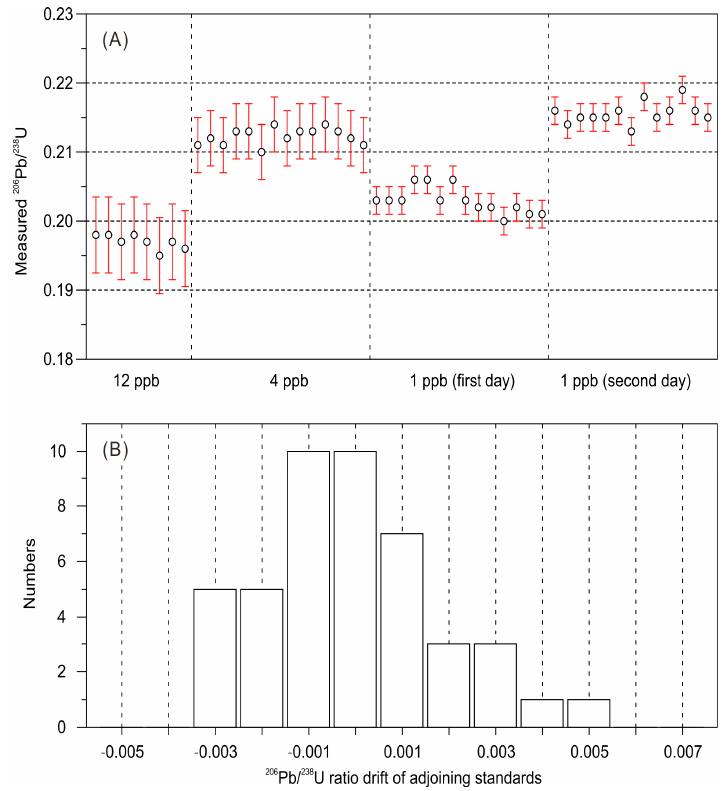
Figure 2. ( a ) Measured 206 Pb/ 238 U ratios of solution standards with different concentrations; ( b ) 206 Pb/ 238 U drifts of adjoining standards. The error bars represent 1 sigma standard error.